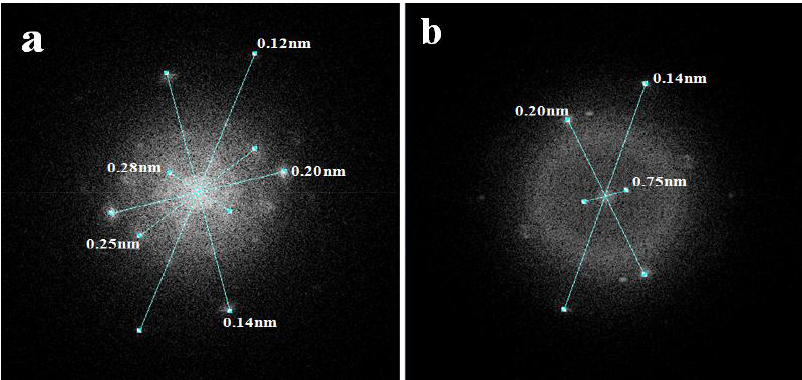
Figure 5. Fourier transform mode for ( a ) AFSG and ( b )